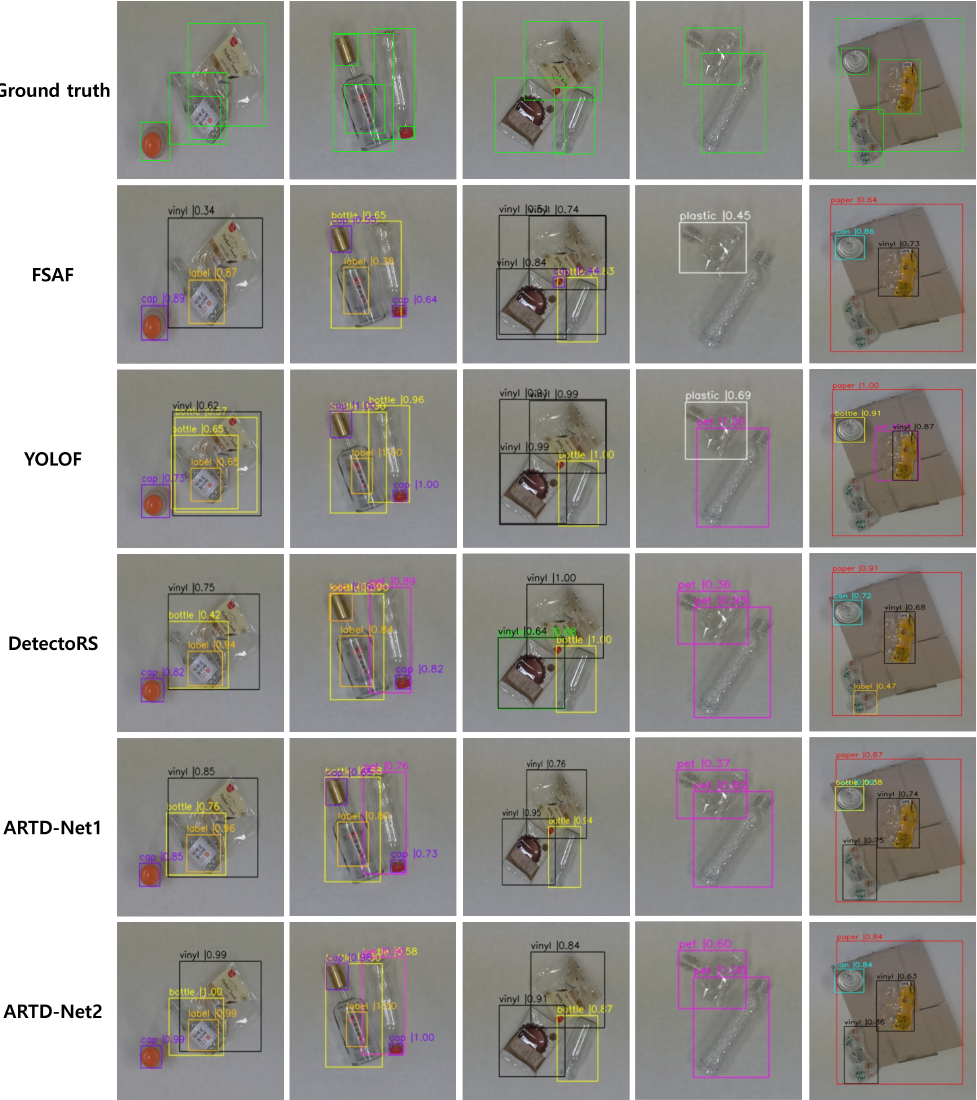
Figure 9. Inference result of ARTD-Net1, ARTD-Net2 and existing deep learning